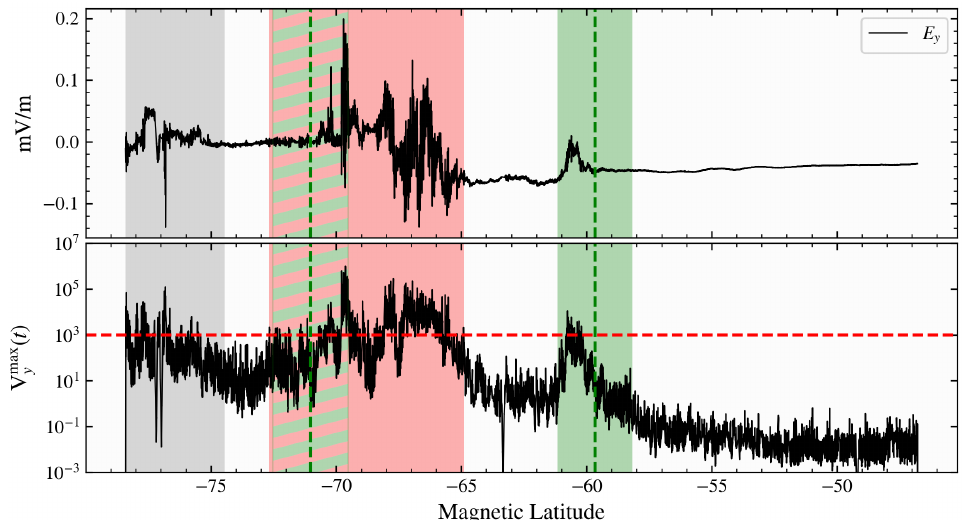
Figure 5. The y component of the electric field from the reference dataset ( top ) and proxy V max y ( t ) of the auroral activity ( bottom ). The horizontal red dashed line denotes the threshold of 1000 set for the clustering detection algorithm. The red area denotes the interval of high auroral activity detected by the clustering algorithm. The gray area denotes the part of the timeseries excluded from the analysis because it is potentially affected by the on/off switching of the instrument. Vertical dashed green lines and green areas denote the latitude of the AO boundaries from GUVI fits (see Figure 1), while striped areas with mixed colors denote overlapping